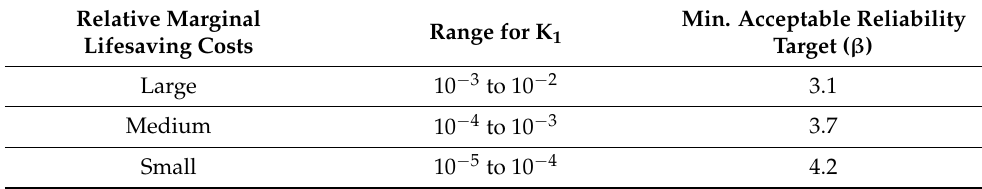
Table 5. Min. acceptable reliabilities for a 1 year reference period, based on marginal lifesaving costs principle, from Fischer et